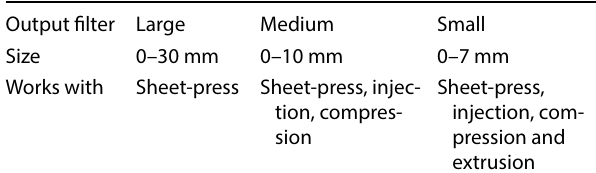
Table 2 Sieves with different sizes of perforations Output filter Large